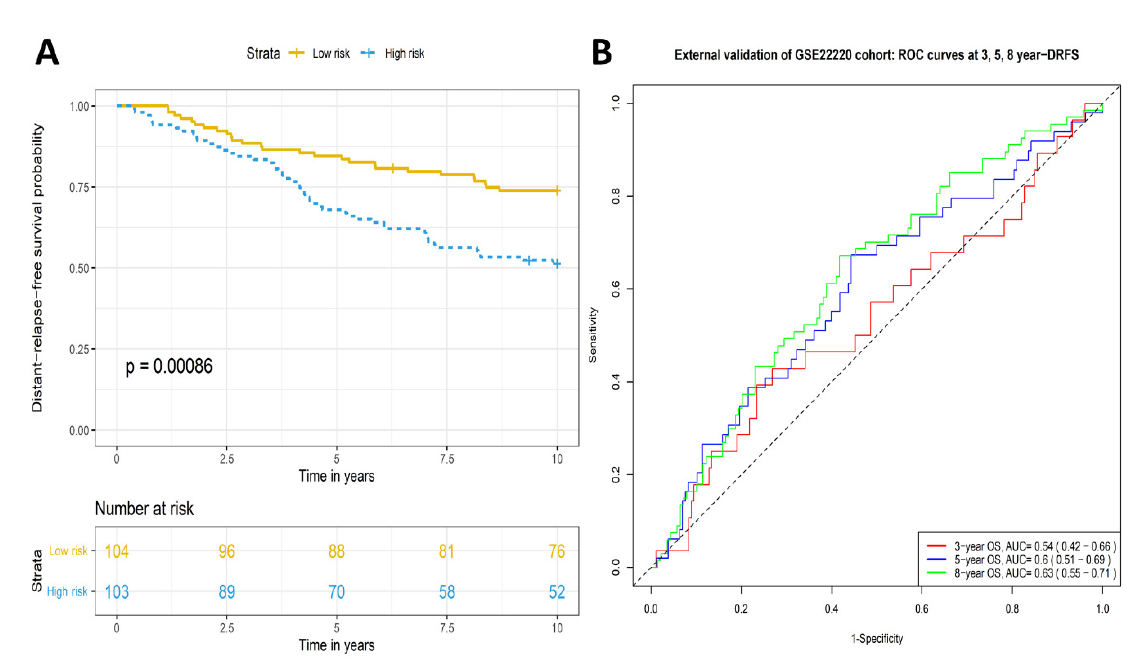
Figure 5. Kaplan–Meier survival analysis and time-dependent ROC curves of the risk groups based on the TRM signature for the external GEO GSE22220 cohort. ( A ) Patients of the high-risk group had significantly shorter DRFS ( p value < 0.001). ( B ) AUCs of time -dependent ROC curves at 3-, 5- and 8-year DRFS were 0.54, 0.60 and 0.63, respectively.